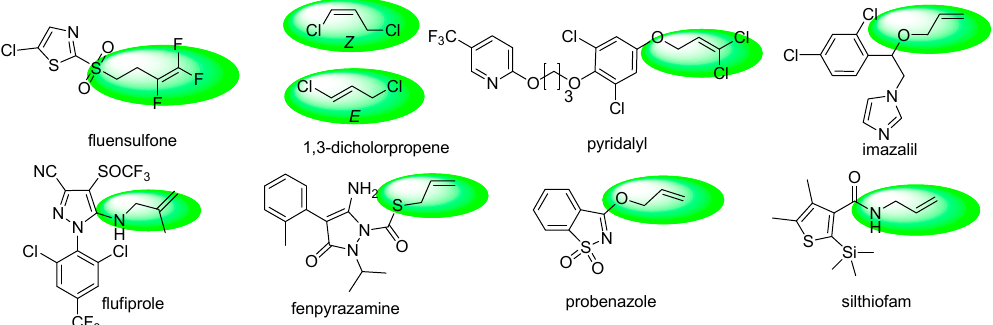
Figure 1. The existing pesticides containing alkenyl / haloalkenyl moieties.